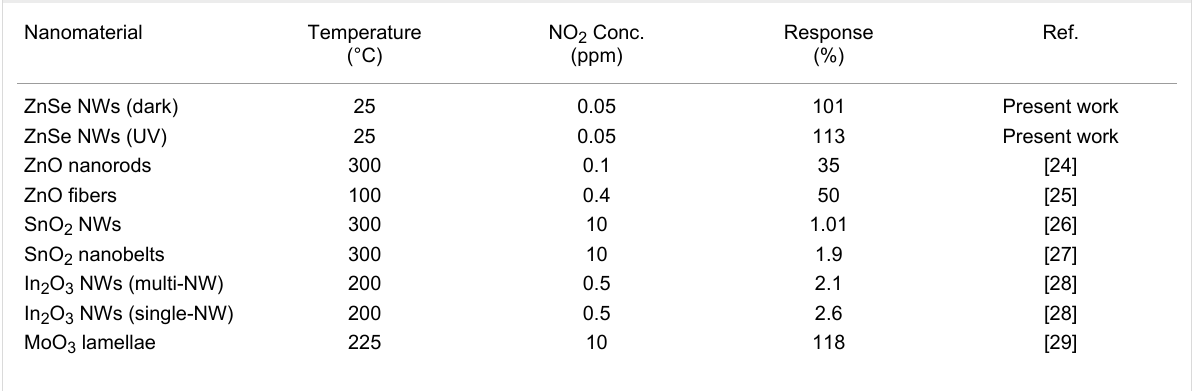
Table 1: Responses of various nanomaterial gas sensors to NO 2 gas.